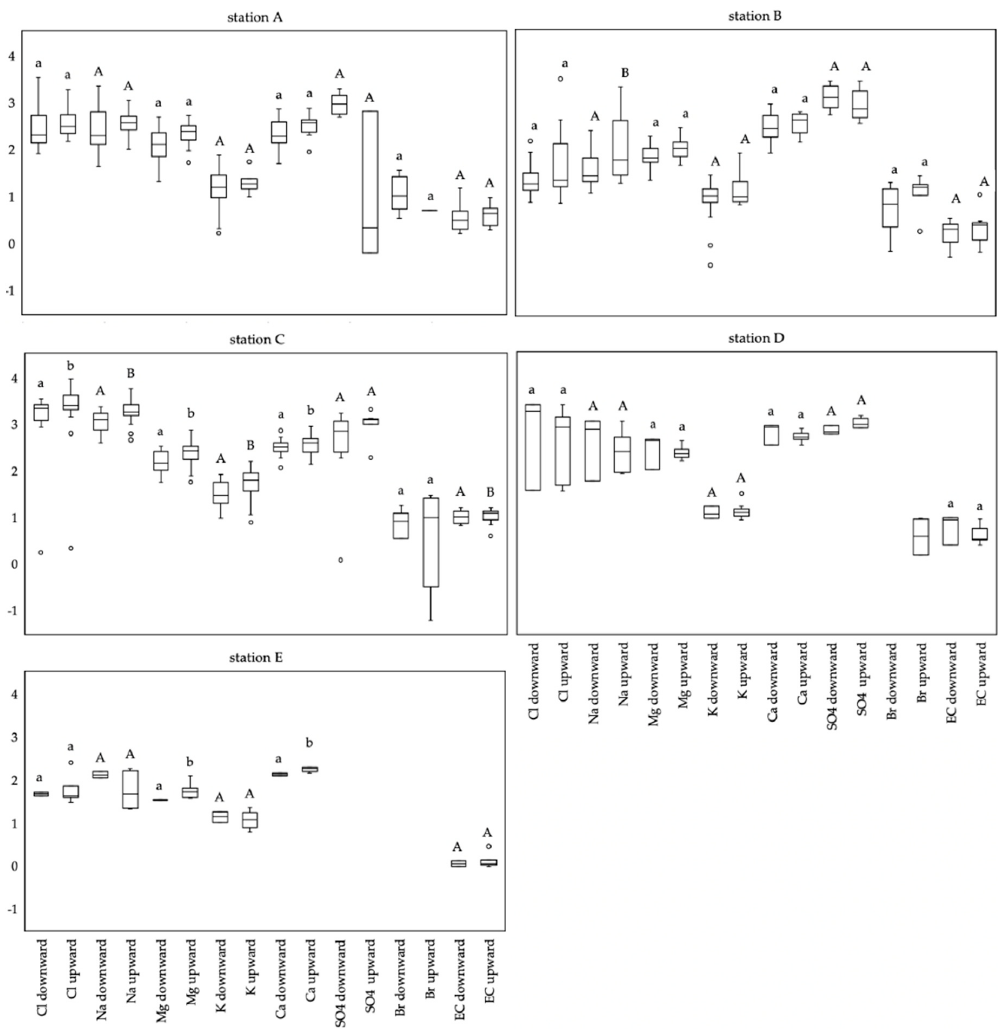
Figure 6. Box plot of ion concentration distributions (logarithmic scale) during upward and downward water movement for each monitoring station. Outliers are plotted as individual points. Letters refer to post-hoc statistical analysis (Kruskal Wallis test). Different letters indicate significant differences ( α = 0.05) between ion and electrical conductivity (EC) movement along the soil profile. Lowercase and capital letters were alternately used to distinguish between each pairwise comparison.